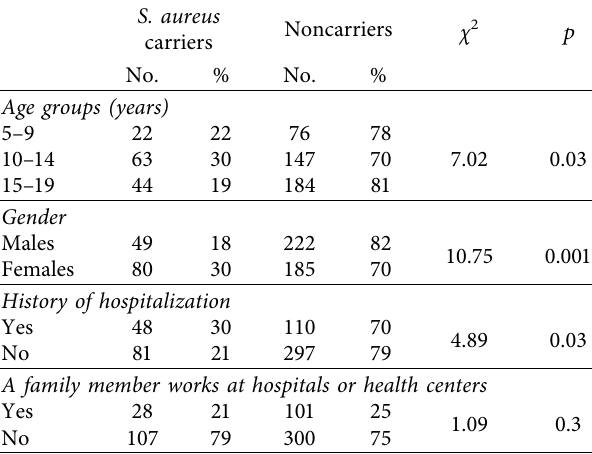
Table 2: Risk factors for nasal carriage of S. aureus among schoolchildren in Sana’a city,